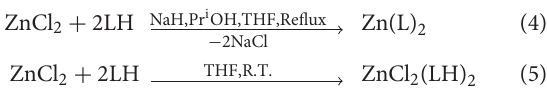
FIGURE 2 | XRD patterns of hexagonal ZnS thin film (JCPDS: 36-1450) obtained by AACVD of Zn(cinnamtscz) 2 at (A) 450 ◦ C, (B) 500 ◦ C, and (C) Zn(4-Clbenztscz) 2 at 450 ◦